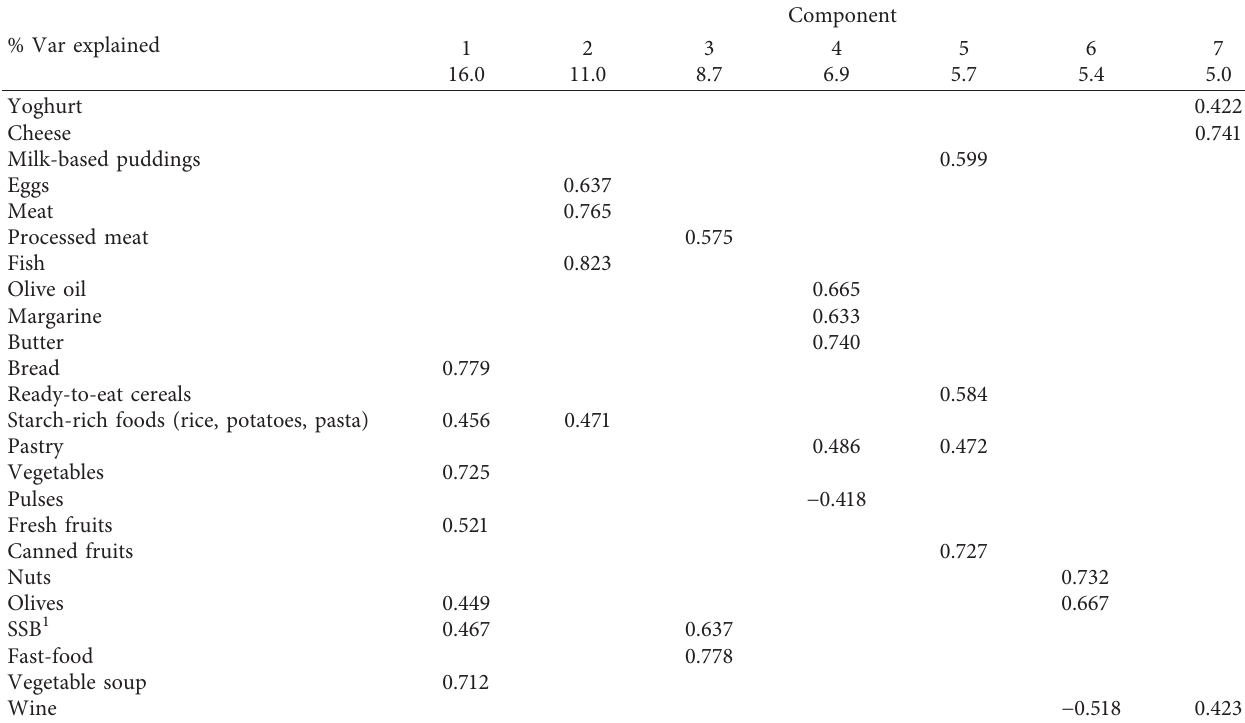
Table 2: Component loadings obtained by principal component analysis with Varimax rotation. Each component was named as “dietary pattern.”